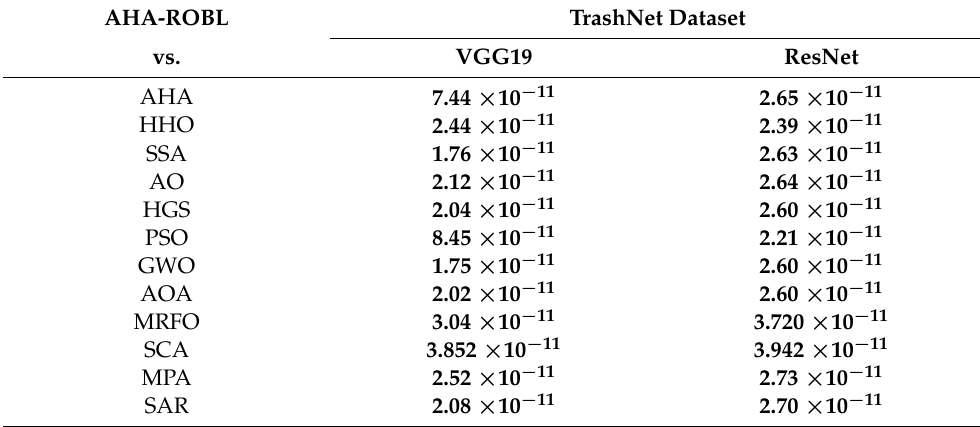
Table 11. Wilcoxon rank sum statistical test.